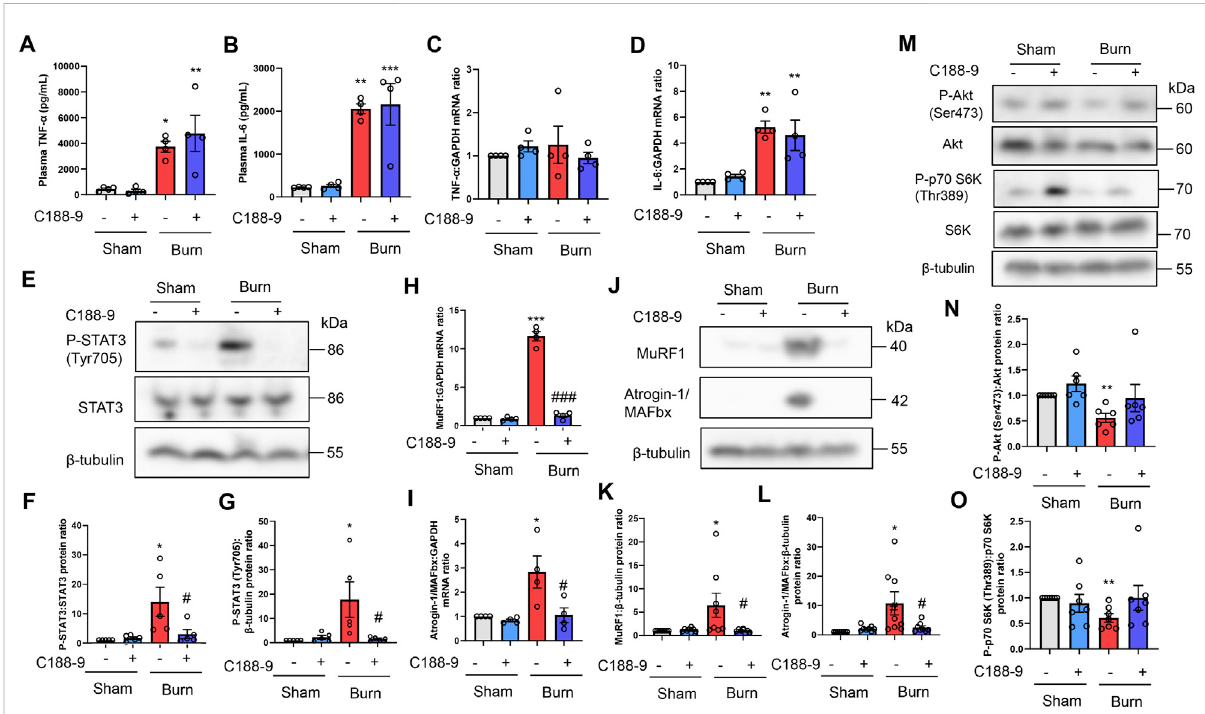
FIGURE 5 C188-9 reduces burn-induced muscle proteolytic pathway activation in mice. Third-degree or sham burns were administered to wild-type C57BL/6 mice (12 – 16-week-old male mice) that were then ip injected with vehicle (5% wt/vol dextrose in distilled water containing 5%